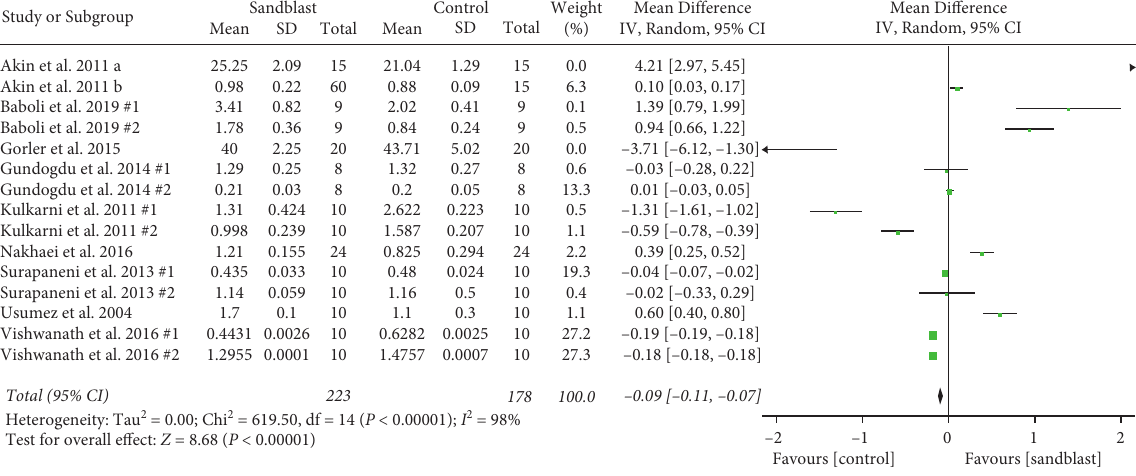
Figure 2: Forest plot for global analysis of tensile bond strength.